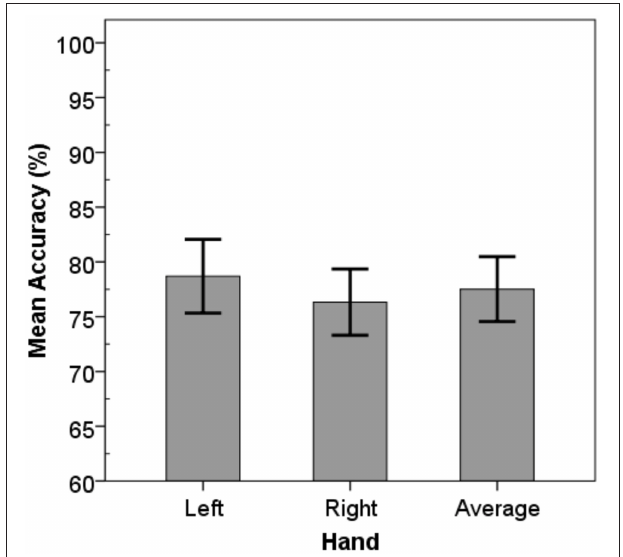
FIGURE 3 | Mean accuracy values. Left hand judgments were significantly more accurate compared to right hand judgments. Error-bars represent 95% confidence